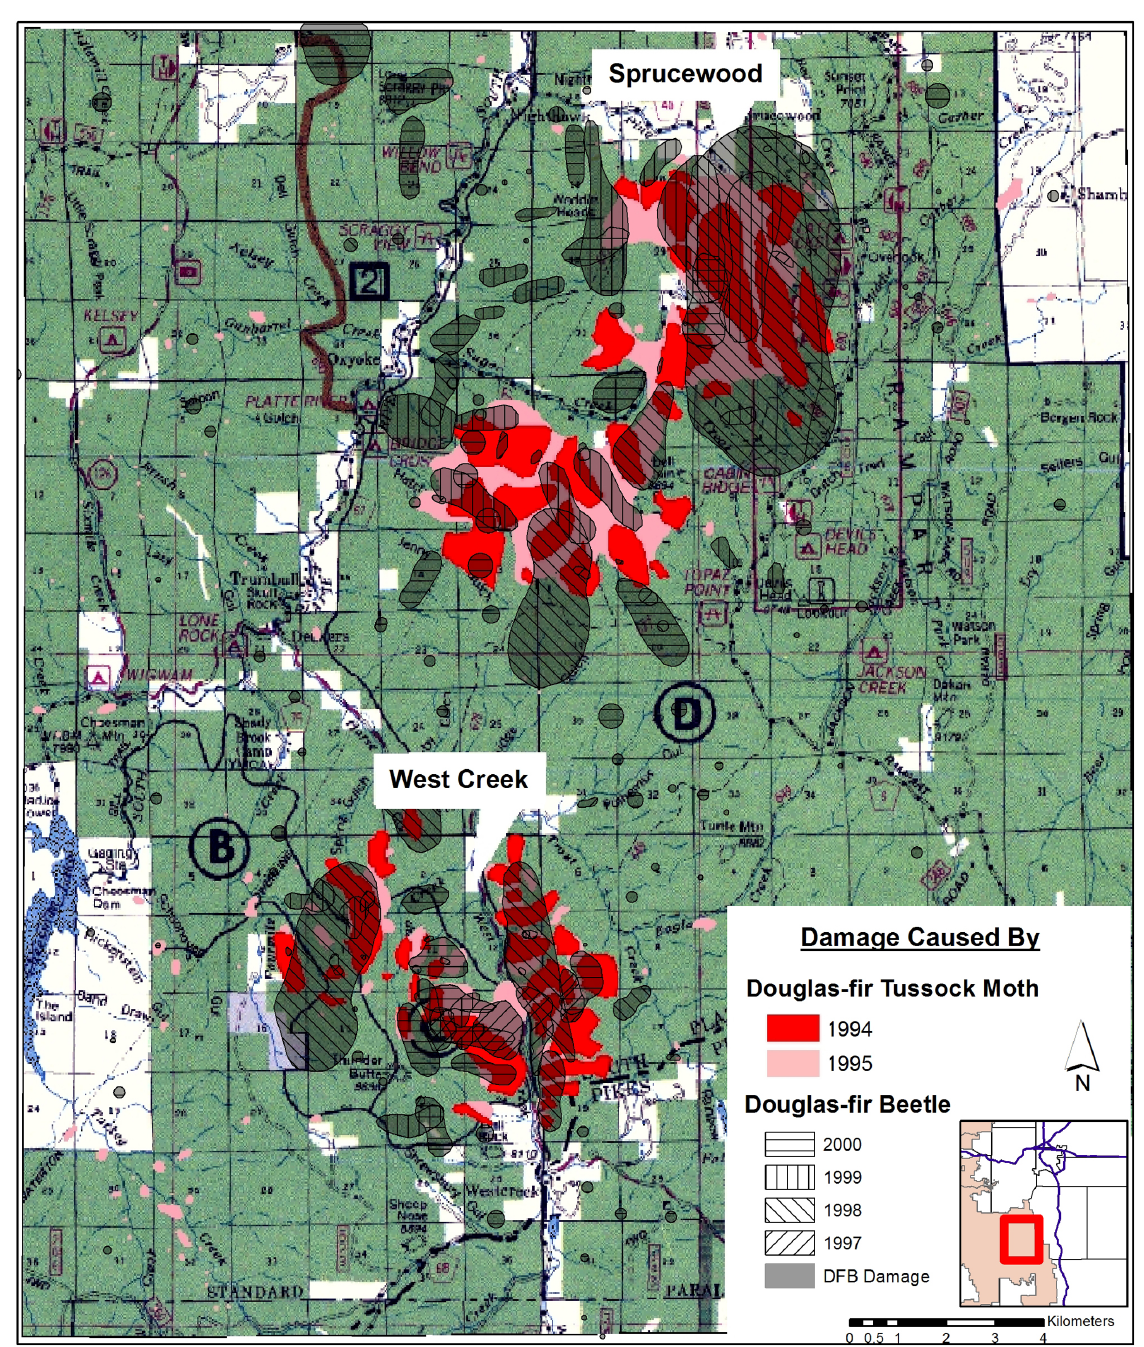
Figure 2. Areas affected by Douglas-fir tussock moth in 1994 and 1995, and by Douglas-fir beetle in 1997–2000, as determined by aerial sketch mapping on the Pike-San Isabel National Forest. Data for Douglas-fir beetle was not available prior to